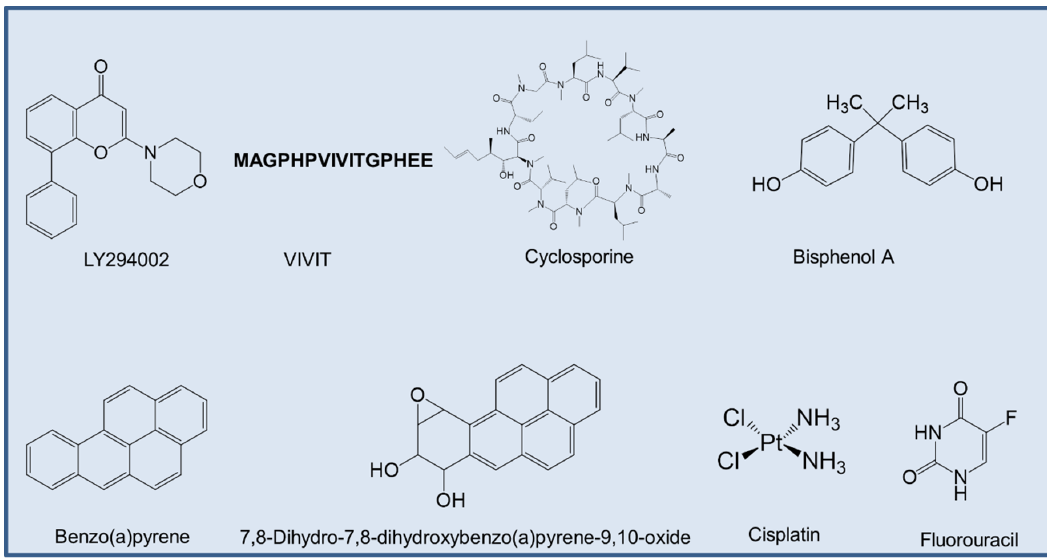
Figure 6. The potential inhibitors of ANLN.